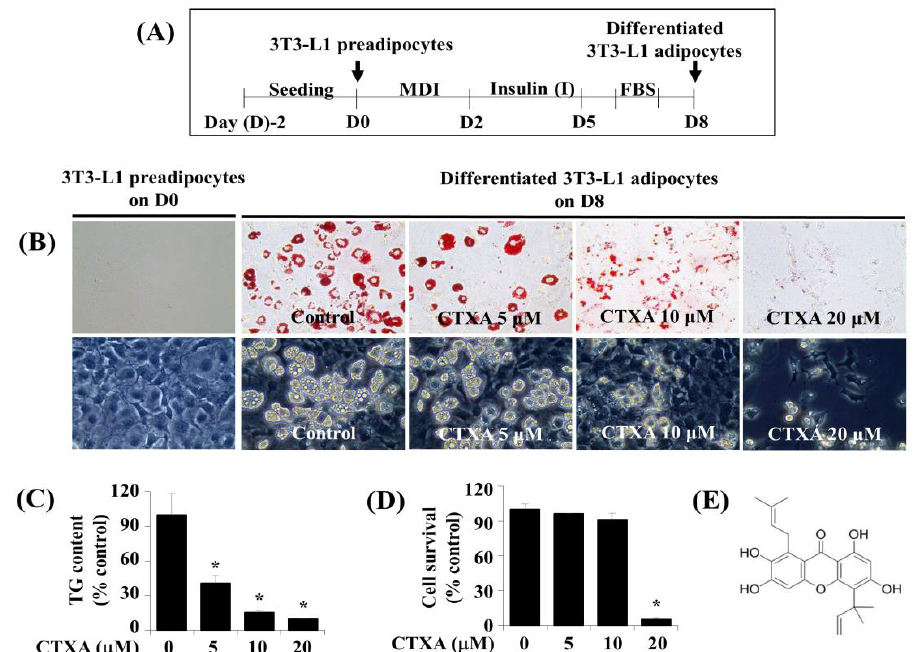
Figure 1. Effects of Cudratricusxanthone A (CTXA) on lipid accumulation, triglyceride (TG) content, and cell survival during 3T3-L1 preadipocyte differentiation. ( A ) The experimental protocol for 3T3-L1 preadipocyte differentiation. ( B ) Measurement of lipid accumulation in 3T3-L1 preadipocytes (D0) and adipocytes (D8) grown in the absence or presence of CTXA at the designated concentrations by Oil Red O staining (Upper panel) or microscopic observation (Lower panel). ( C ) Measurement of TG content in 3T3-L1 adipocytes (D8) that were grown in the absence or presence of CTXA at the designated concentrations by Adipo-red assay. Each experiment was conducted independently in triplication. Data are mean ± SE of three independent experiments. * p < 0.05 compared to the value of vehicle control at the indicated time. ( D ) Measurement of the number of live cells in 3T3-L1 adipocytes (D8) that were grown in the absence or presence of CTXA at the designated concentrations by cell survival analysis. Each experiment was conducted independently in triplication. Data are mean ± SE of three independent experiments. * p < 0.05 compared to the value of vehicle control at the indicated time. ( E ) The c hemical structure of CTXA.